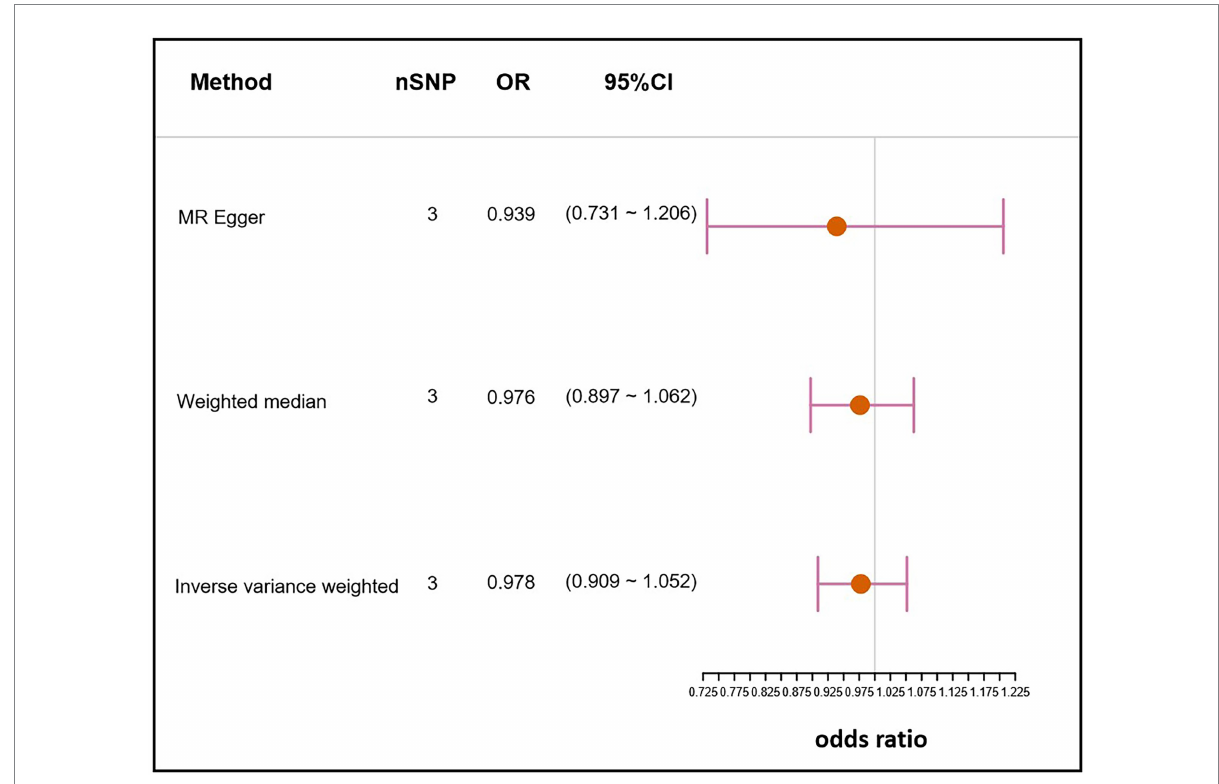
FIGURE 3 Mendelian randomization result of the effect of NAFLD on H. pylori infection. nSNP, the number of SNPs used in the analysis. OR, the odds ratio. 95% CI, 95% confidence